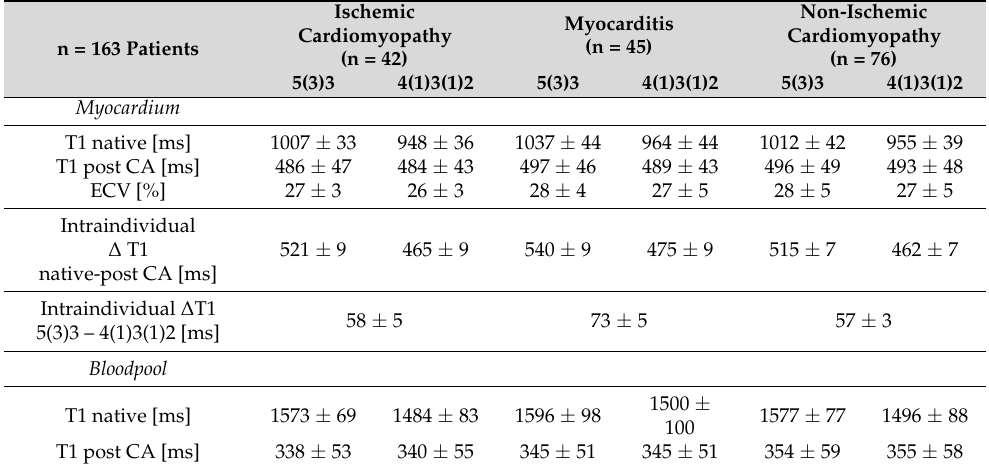
Table 4. T1 mapping in patients by